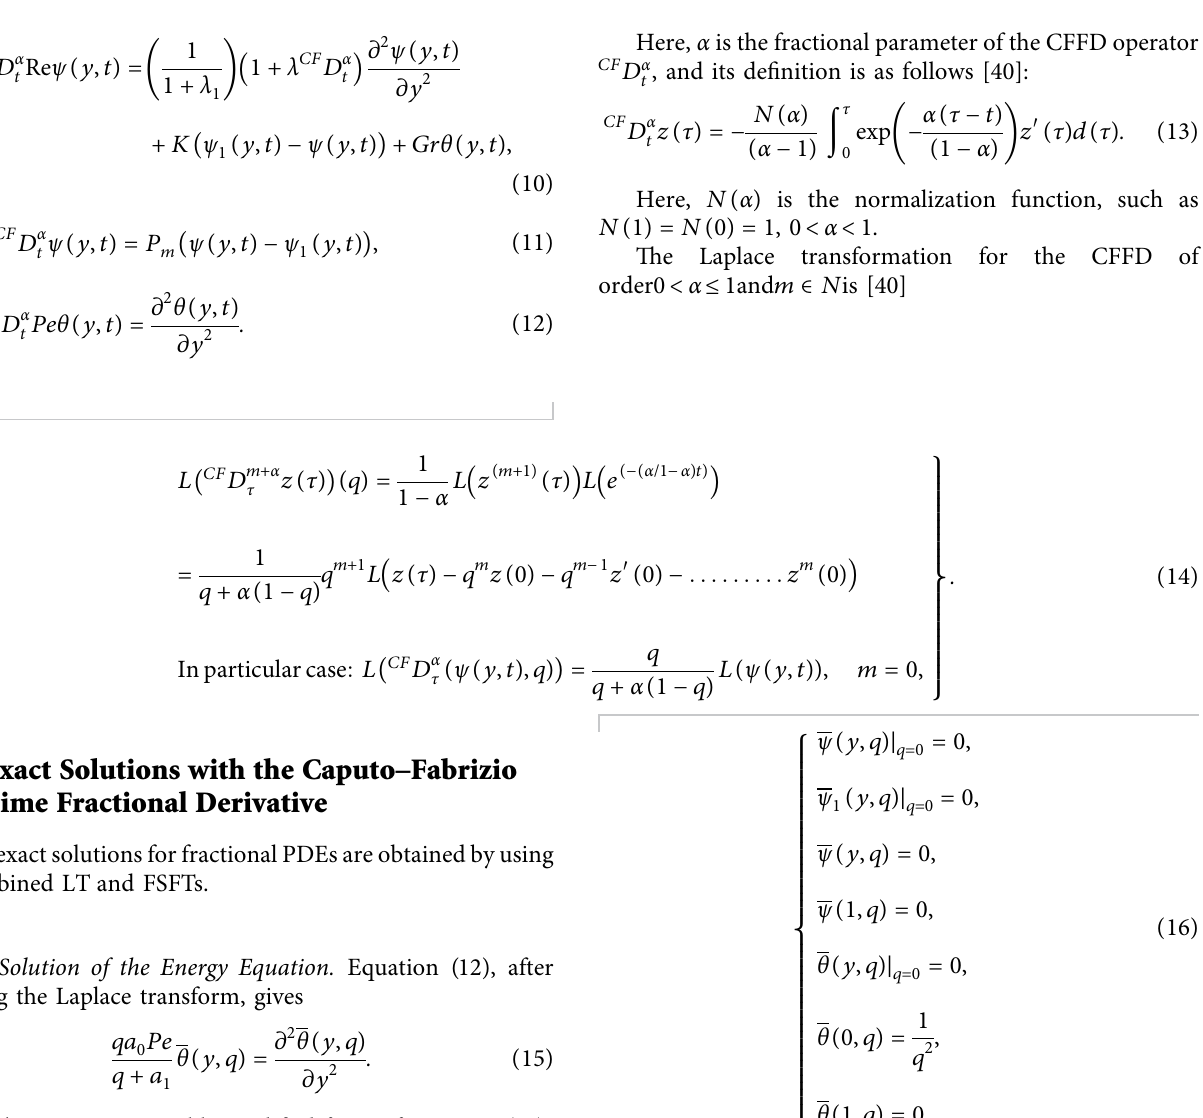
Figure 1: Te problem’s descriptive